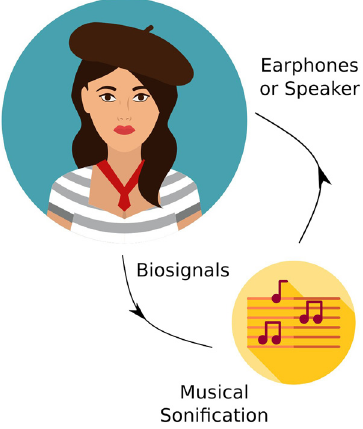
Figure 2: Feedback of sexual arousal using soni fi cation.